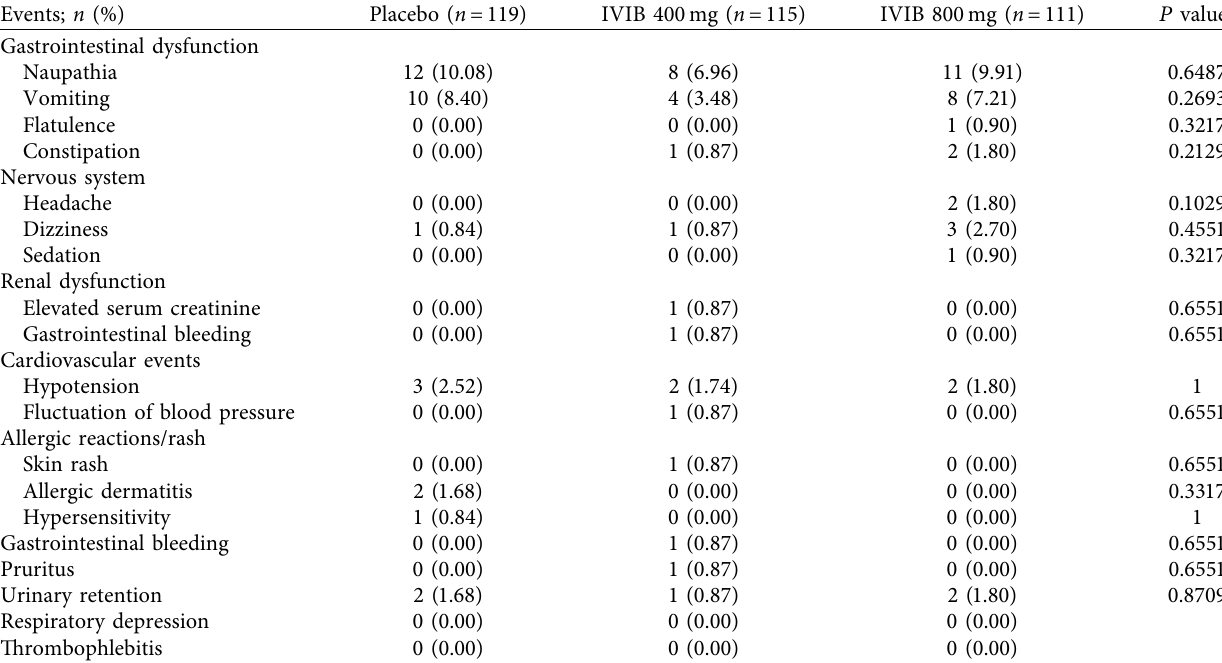
Table 2: AEs related to IVIB and morphine. (%) of